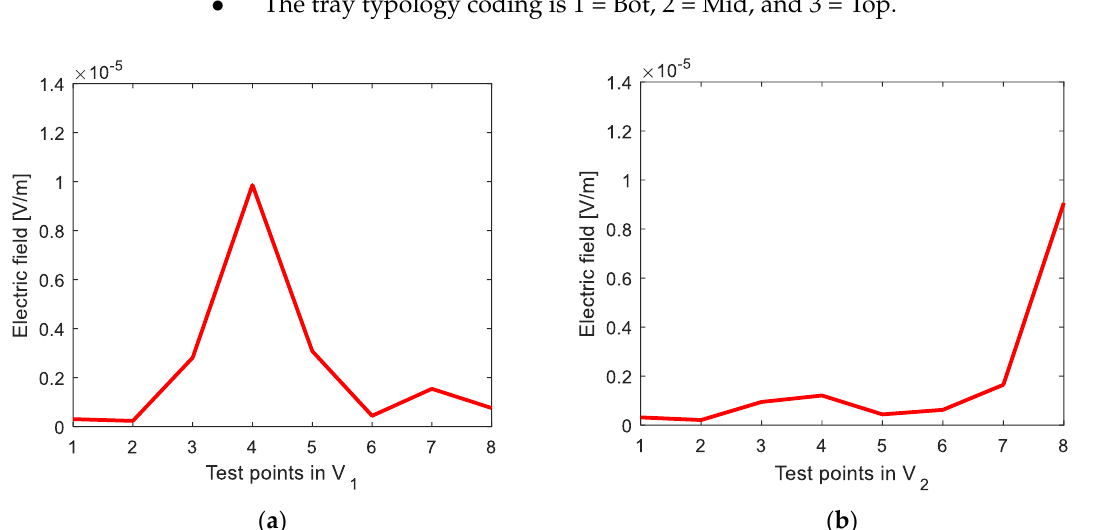
Figure 5. The magnitude of the electric field in ( a ) the N 1 test points of volume V 1 and ( b ) the N 2 test points of volume V 2 , due to the optimal SOGA solution C SOGA in Equation (6).